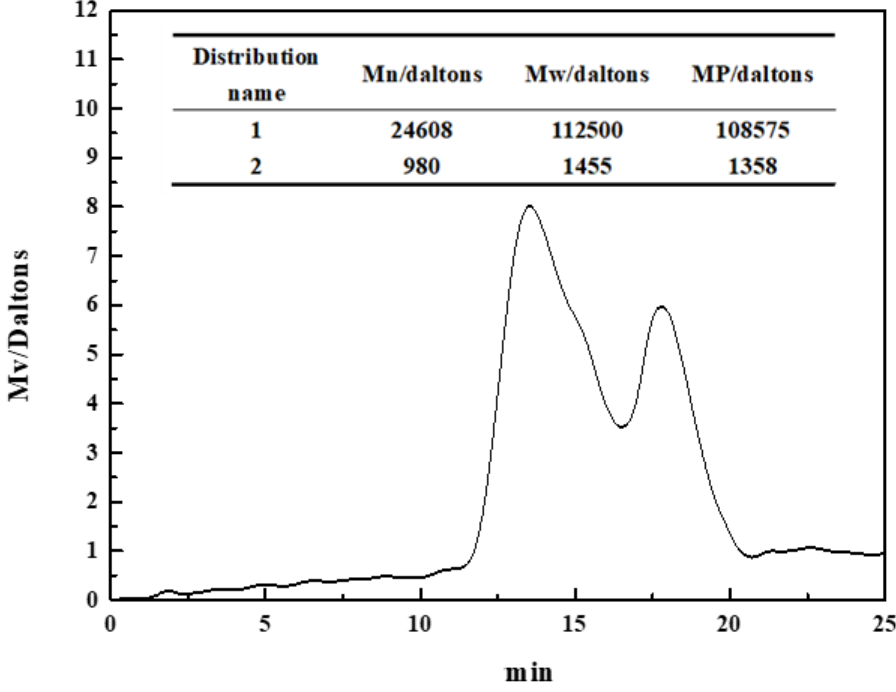
Figure 3. The molecular weight of pullulan.